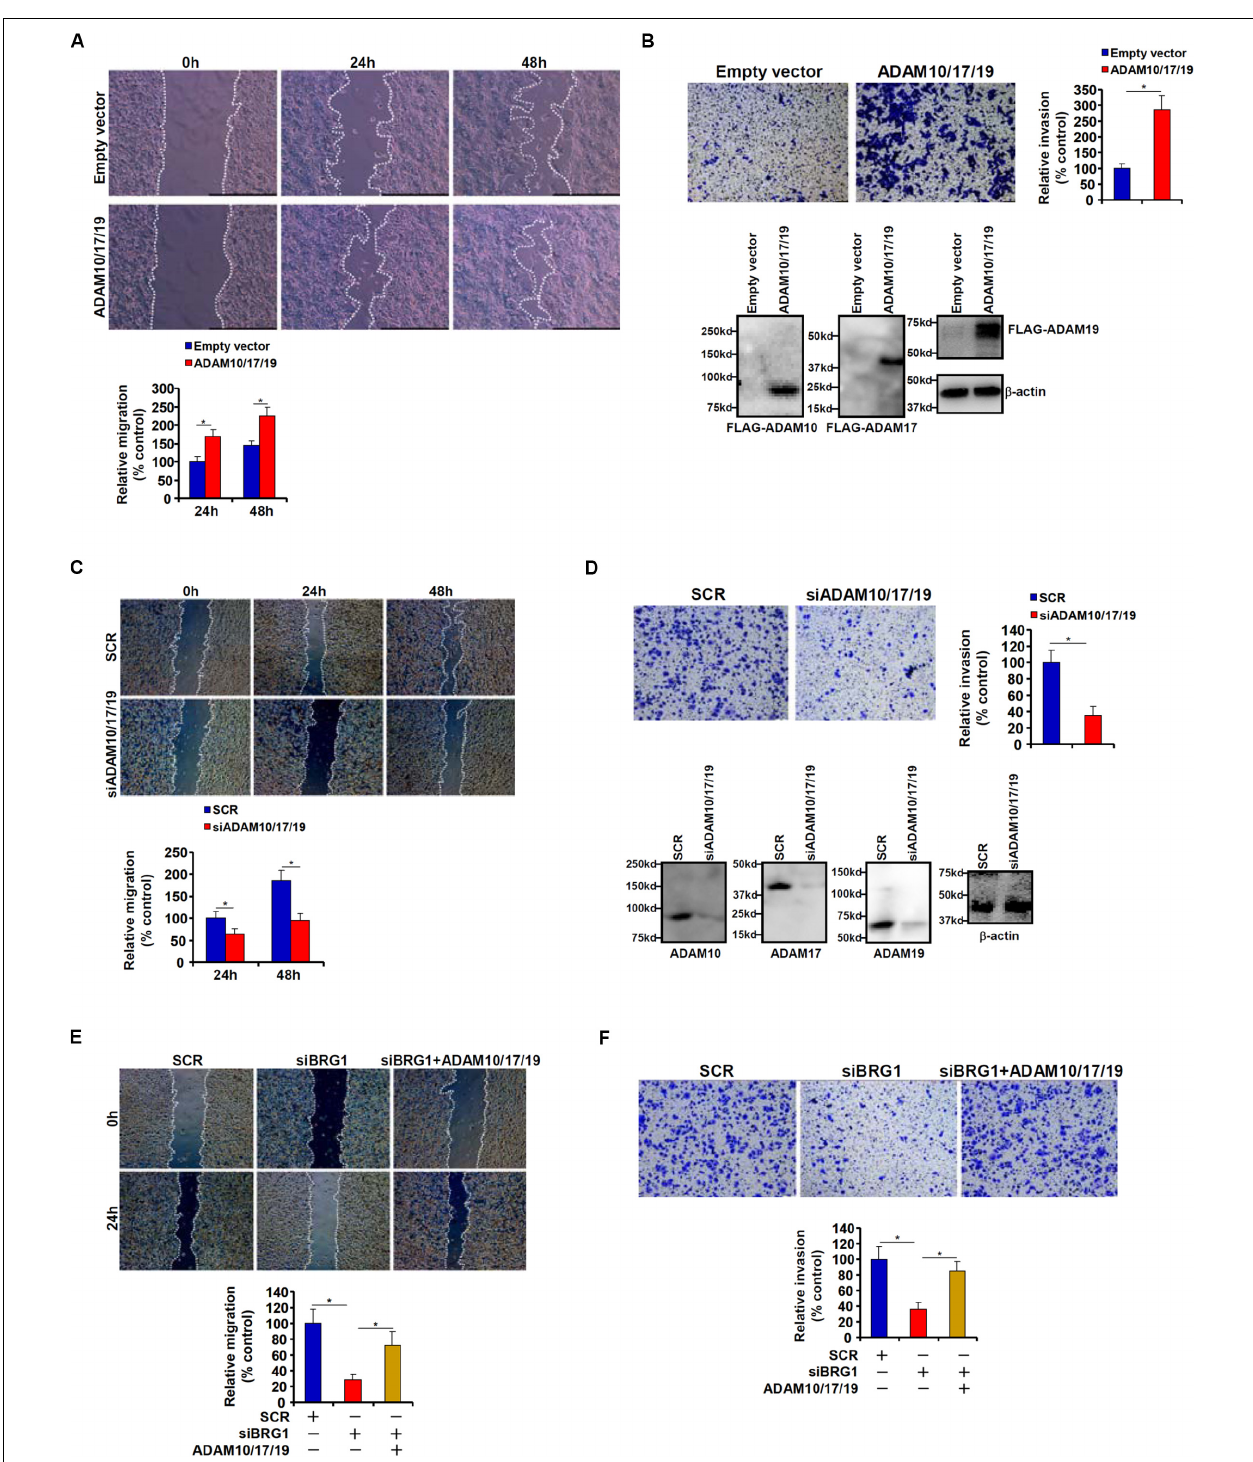
FIGURE 2 | ADAM promotes colorectal cancer cell migration and invasion. (A,B) HCT116 cells were transfected with indicated expression constructs or an empty vector (EV). Cell migration was evaluated by wound healing assay (A) . Cell invasion was evaluated by Boyden Chamber assay (B) . Inset, Western blotting was performed with anti-FLAG and anti– β -actin. (C,D) SW480 cells were transfected with indicated siRNAs or scrambled siRNA (SCR). Cell migration was evaluated by wound healing assay (C) . Cell invasion was evaluated by Boyden Chamber assay (D) . (E,F) SW480 cells were transfected with indicated siRNAs in the presence or absence of ADAM expression constructs. Cell migration was evaluated by wound healing assay (E) . Cell invasion was evaluated by Boyden Chamber assay (F) . Data represent averages of three independent experiments, and error bars represent SEM ( p < 0.05, two-tailed Student t test).